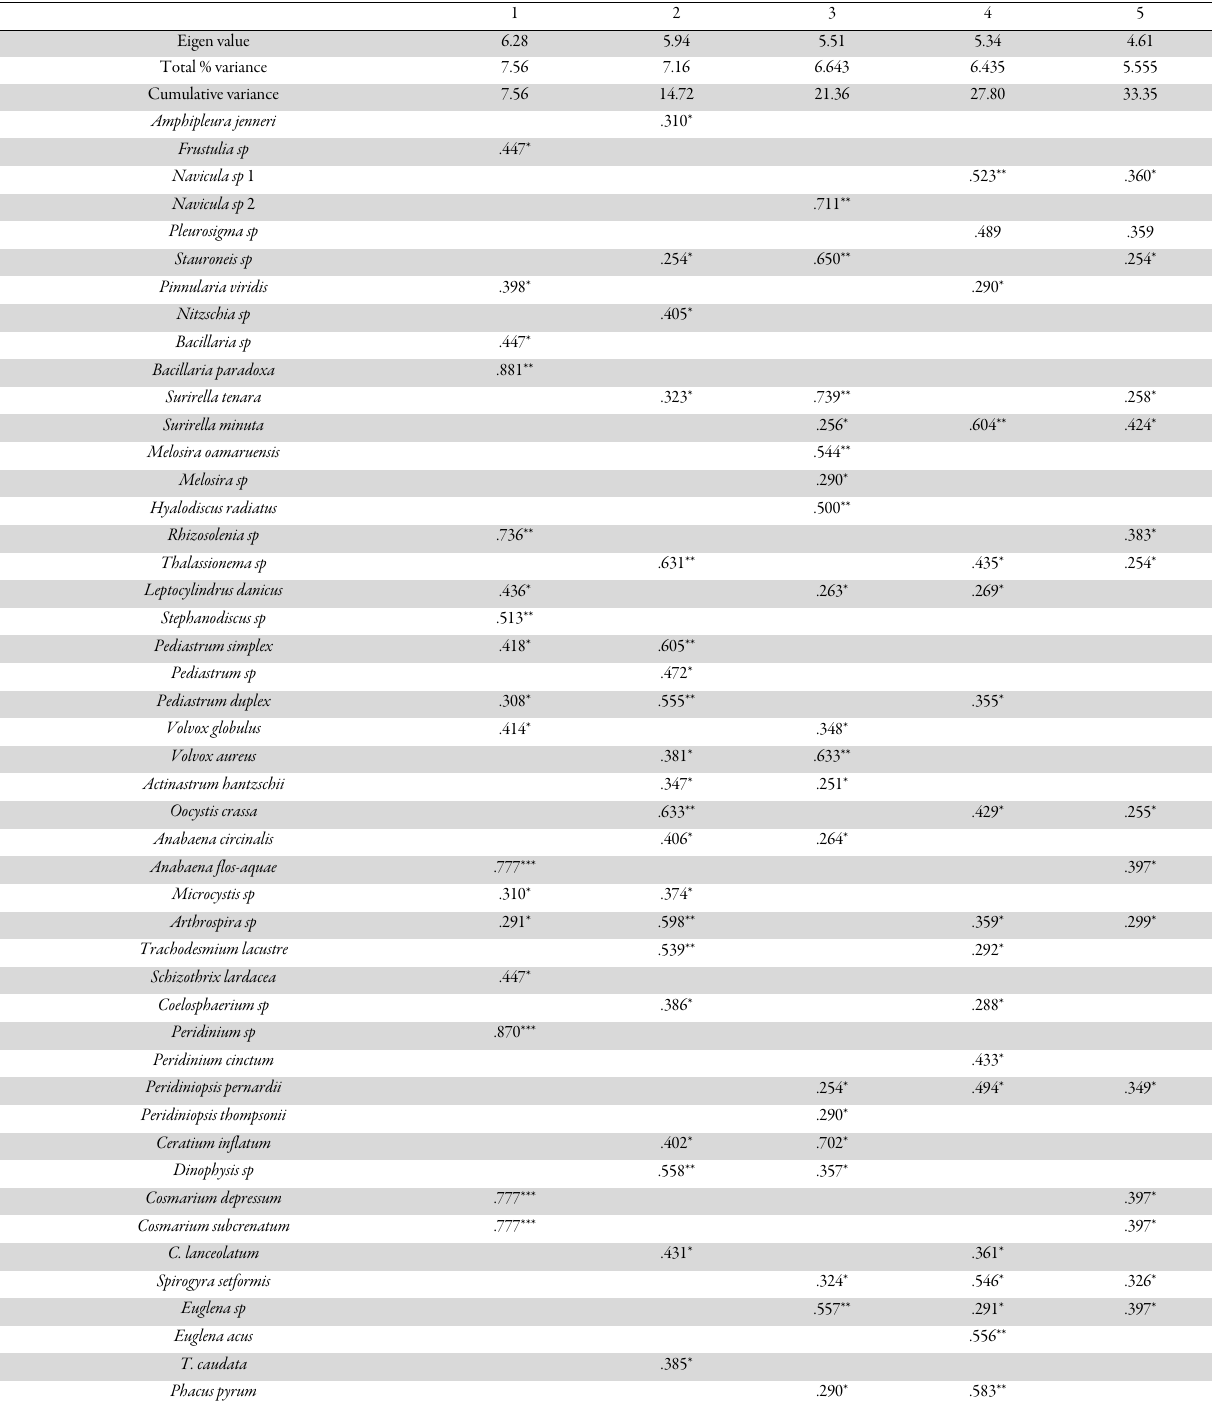
Table 6. Principal component analysis for the phytoplankton species based on